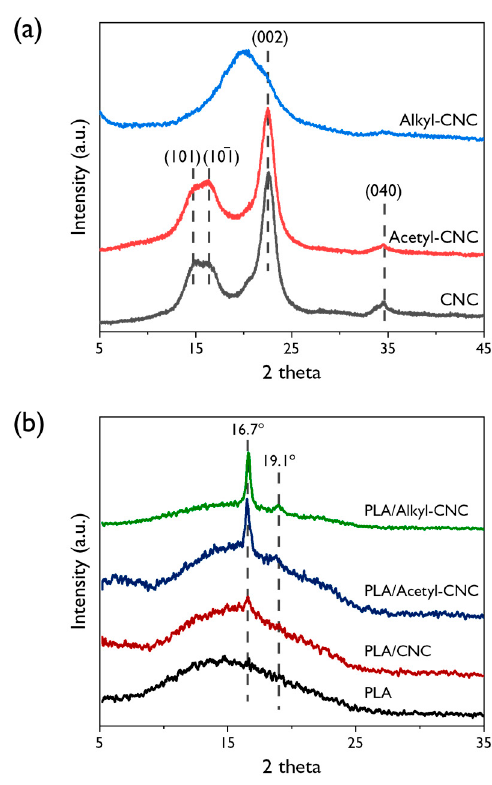
Figure 4. XRD patterns for the CNC, acetyl-CNC and alkyl-CNC ( a ), and XRD patterns for the PLA and PLA/CNC nanocomposites ( b ).